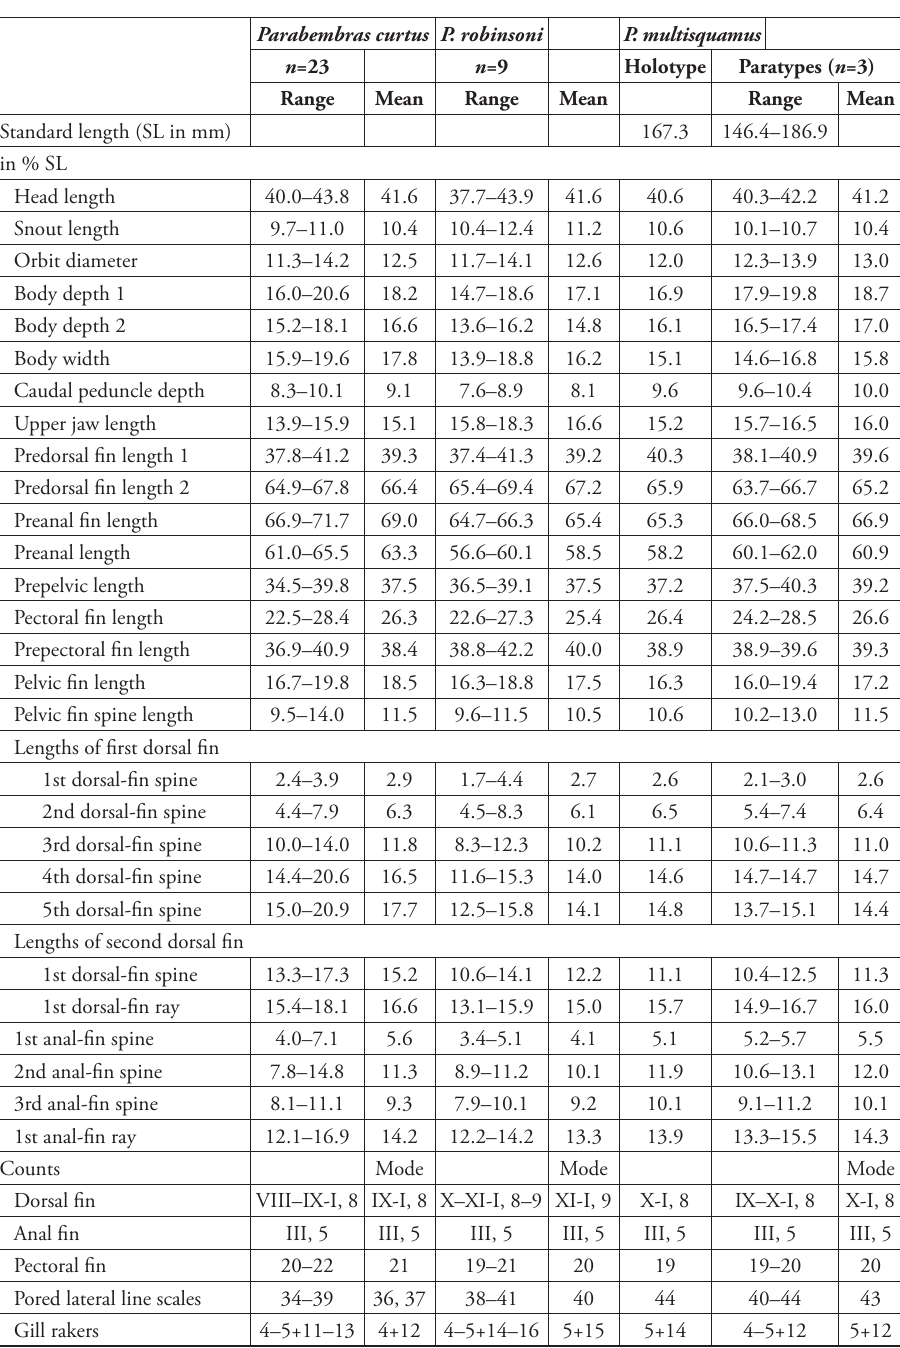
Table 1. Counts and measurements of three species of Parabembras